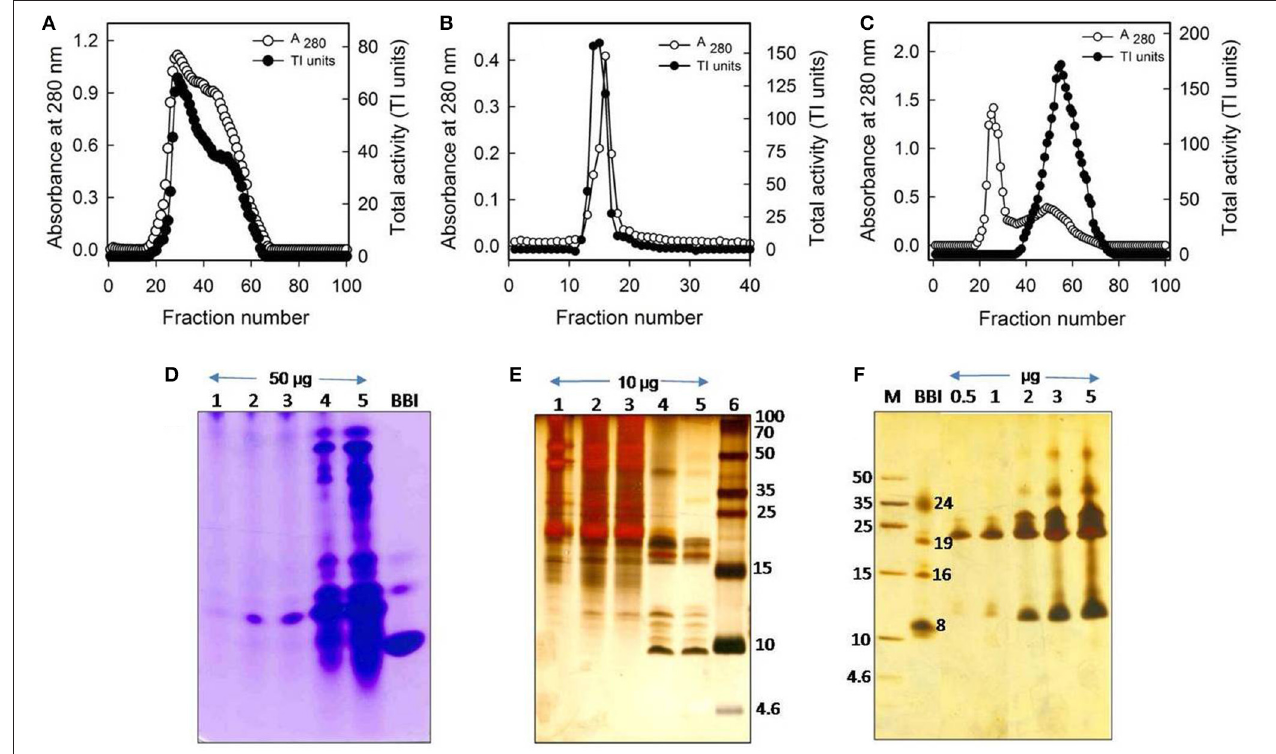
FIGURE 1 | Purification profile of trypsin-specific PIs (CpPI 63), Gelatin native PAGE, and Tricine SDS-PAGE. Elution profile of (A) DEAE-cellulose column loaded with 20–70% (NH 4 ) 2 SO 4 fraction; (B) trypsin-Sepharose 4B column loaded with PI fraction (No. 20–63) pool from the ion-exchange column; (C) Sephadex G-50 column loaded with PI fraction (No. 12–18) pool from the affinity column; (D) activity staining of Gelatin native PAGE (12.5%) and; (E) Tricine SDS-PAGE (18%) showing different fractions of the purification protocol. Lanes 1-6 are loaded with crude PI protein extract, 20–70% (NH 4 ) 2 SO 4 protein fraction, active fraction pool against trypsin from anion exchange column, affinity column, gel-filtration column (fraction No. 38–73), Marker protein, soybean BBI (2 µ g) or Puregene molecular weight marker, respectively. Gels were stained with CBB R250 stain or silver nitrate; (F) Tricine SDS-PAGE (18%) showing the consequent increase in intensity of PI bands and appearance of their oligomers with the progressive increase in concentration of CpPI 63 (lanes 3–7). Lanes 1 and 2 are loaded with molecular weight marker (Puregene) and soybean BBI (2 µ g), a PI marker, as the mobility of PIs is known to vary as compared to other proteins. The molecular mass of monomeric (8kDa), dimeric (16kDa), and trimeric (24kDa) forms of BBI is indicated. An additional band at ∼ 19kDa might be a contamination of Kunitz inhibitor in BBI preparation, which is procured commercially. The data shown here are representative of a purification protocol for CpPI 63 from four experiments performed independently as described in Table 1 .